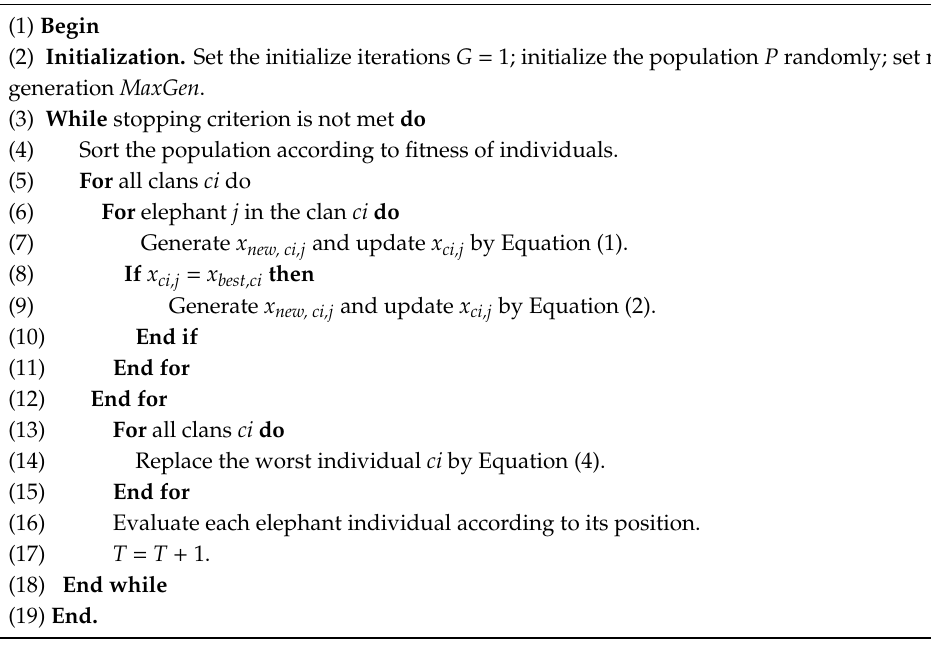
Algorithm 1 . Elephant herding